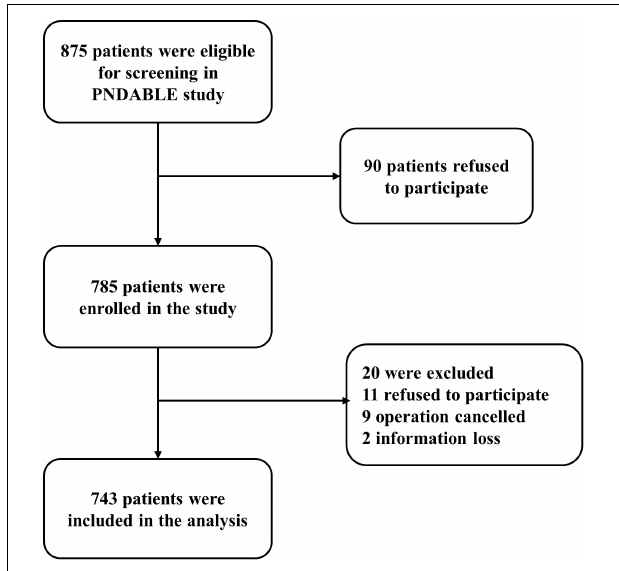
FIGURE 1 | Flow diagram of PNDABLE